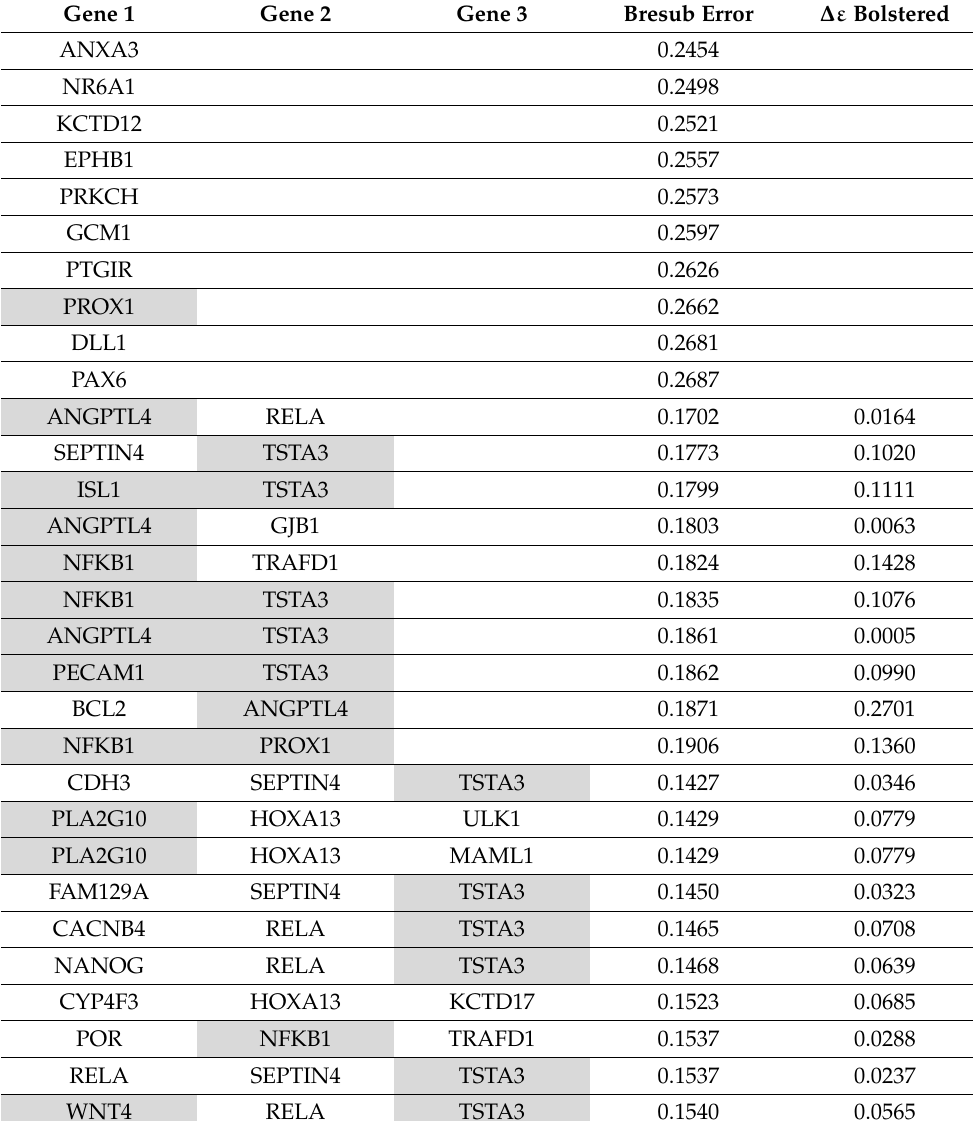
Table 3. Top ten one-, two- and three-gene linear discriminant analysis classifiers in low-ENL excreters are shown. Highlighted genes were also differentially expressed after flaxseed lignan extract vs. placebo treatment in low-ENL excreters. “bresub error” indicates the bolstered resubstitution error for the respective classifier (classifiers are ranked according to that error measurement); “ ∆ ε bolstered” represents the decrease in error for each gene set relative to its highest ranked subset of